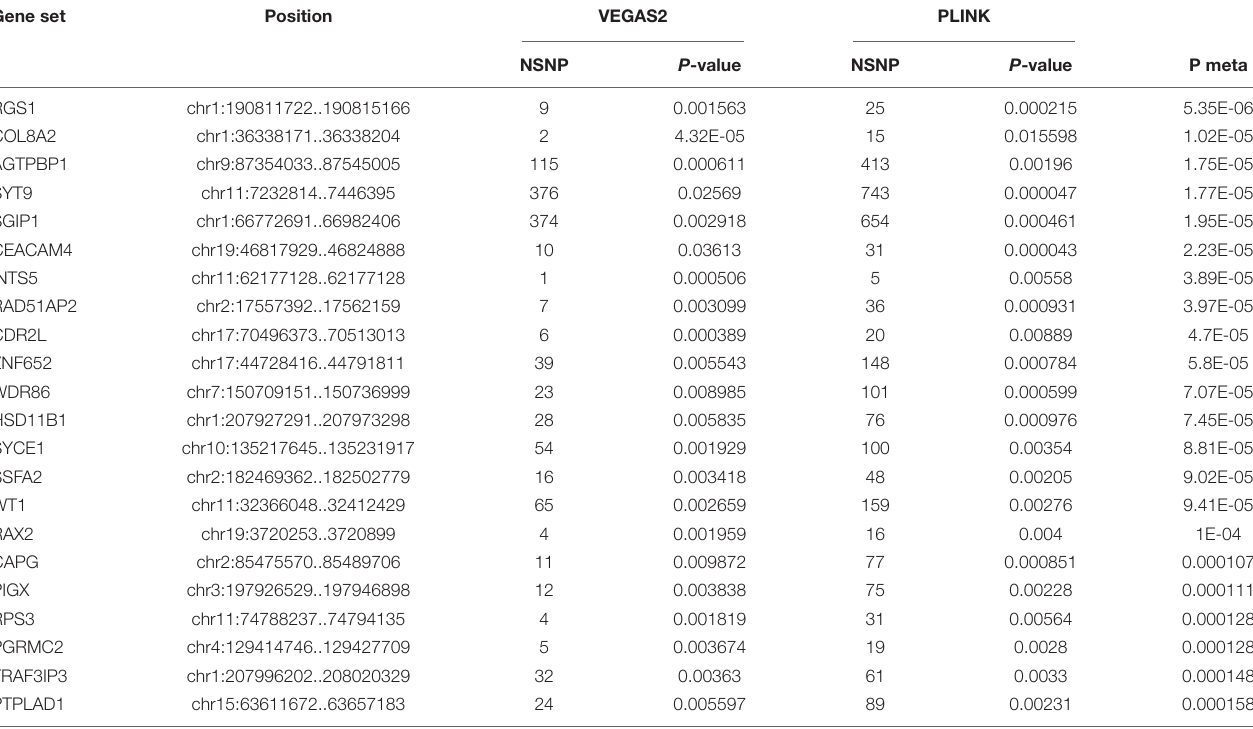
TABLE 3 | Comparison of significant shared gene sets in AQP4 negative NMOSD produced with VEGAS2 and PLINK. Gene set Position